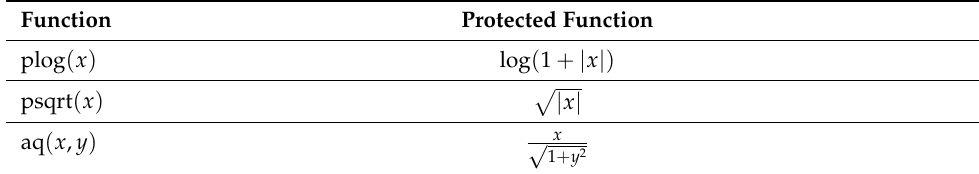
Figure 2. The grammar for the glucose forecasting model (Equation (5)). Table 2. Protected functions used in the